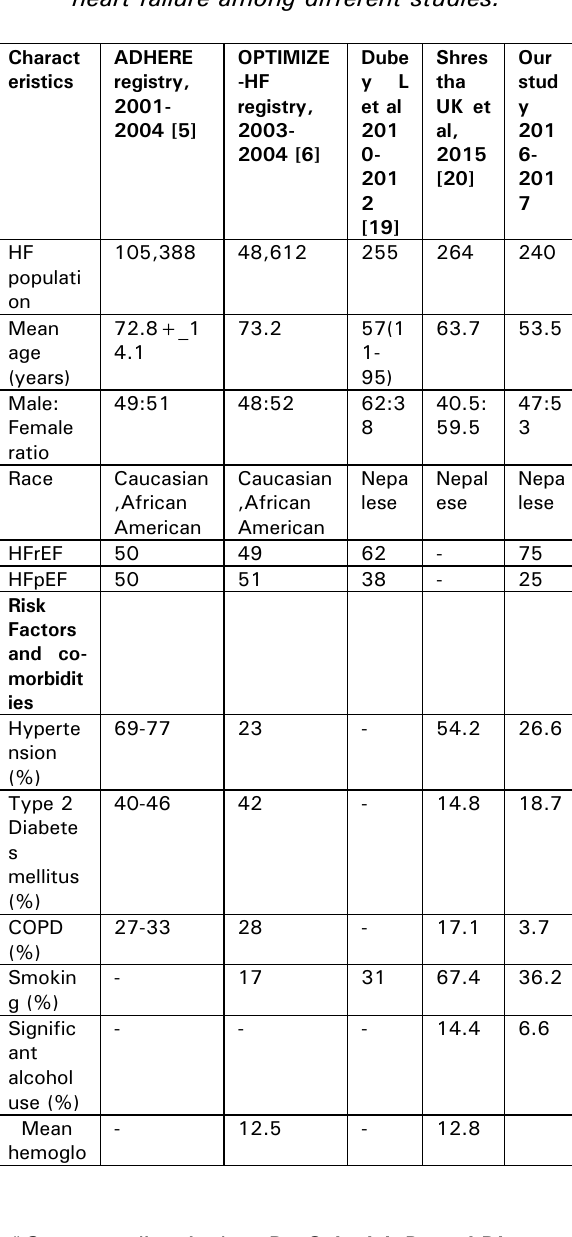
Table 5. Comparison of characteristics and prevalence of co-morbidities in patientswith heart failure among different